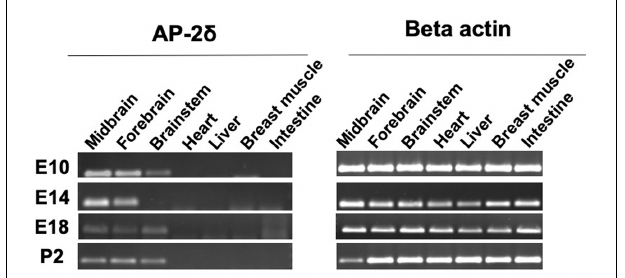
FIGURE 1 | RT-PCR analysis of AP-2 δ . RNA was isolated by using Reliaprep TM Tissue Miniprep System. (Left panel) AP-2 δ expression in various tissues is demonstrated by a 137-bp PCR amplicon. Data shown for embryonic day 10–18 (E10–E18) and post-hatch day 2 (P2). (Right panel) β -actin (300 bp, left) serves as a